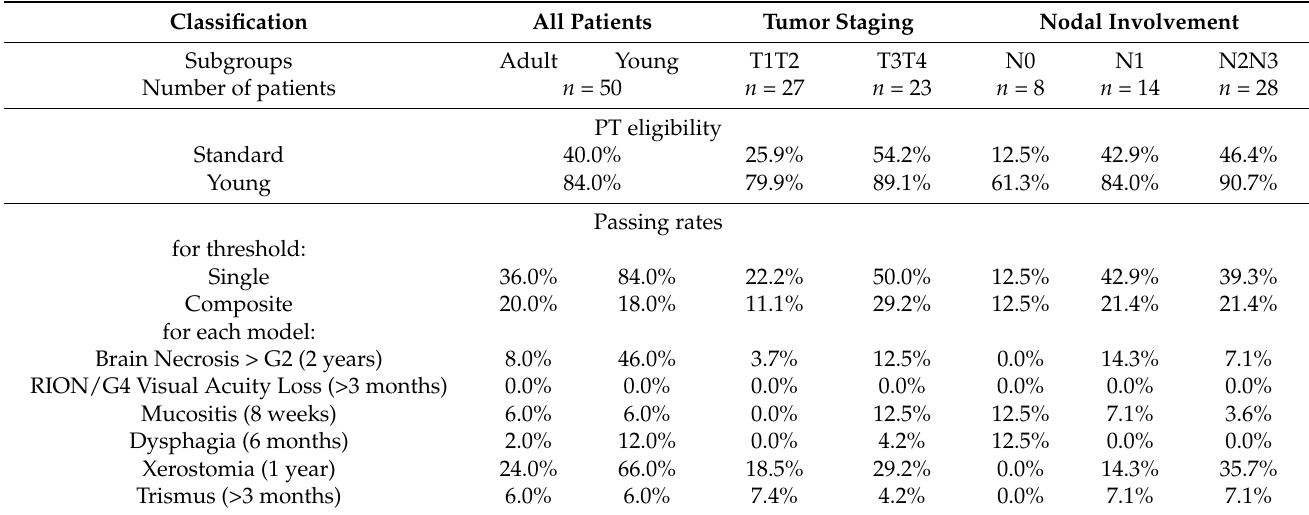
Table 3. The percentage of patients eligible for PT with MBS strategy with the standard and the “young” threshold values. In addition, passing rates applying the single or the composite threshold and for each NTCP model were reported. Values were shown relative to each subgroup of the cohort